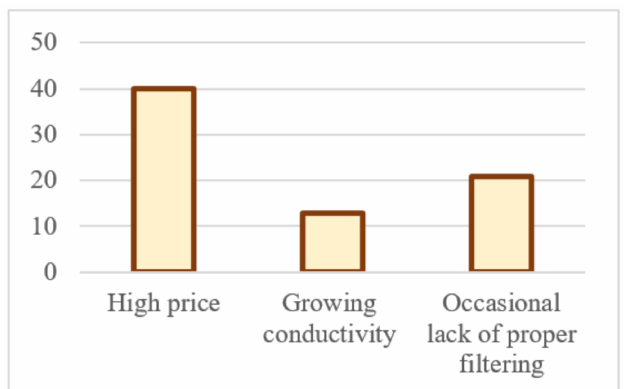
Figure 5. Combined data of the most disadvantageous drawbacks of using reclaimed water perceived by